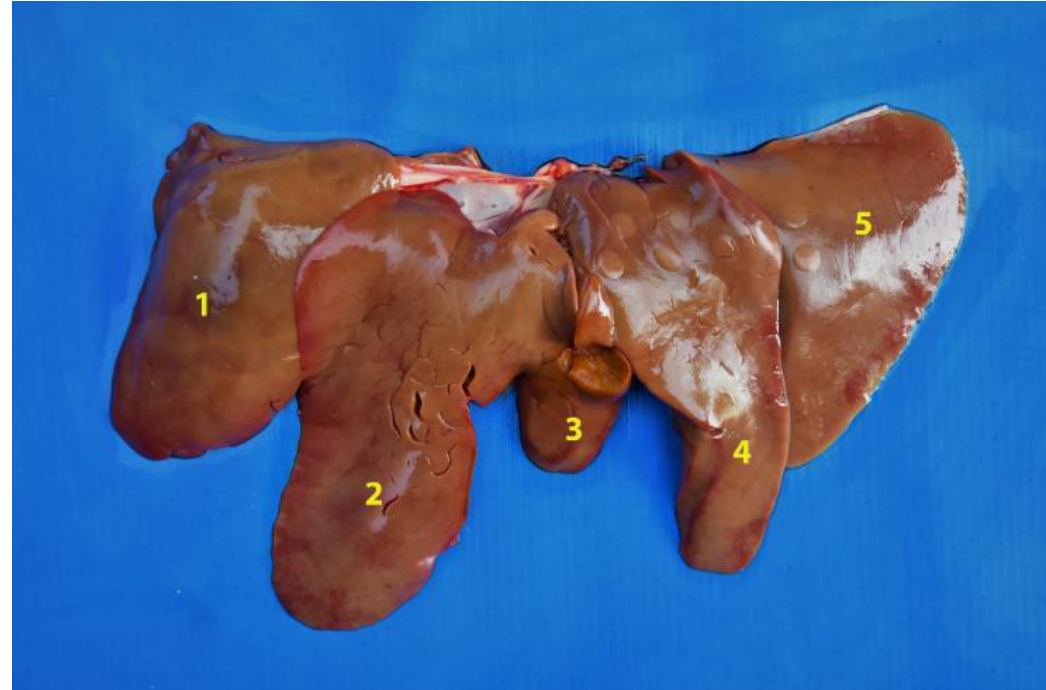
Figure 24. Diaphragmatic face of the liver. ( 1 ) Right lateral lobe; ( 2 ) right medial lobe; ( 3 ) quadrate lobe; ( 4 ) left medial lobe; ( 5 ) left lateral lobe.